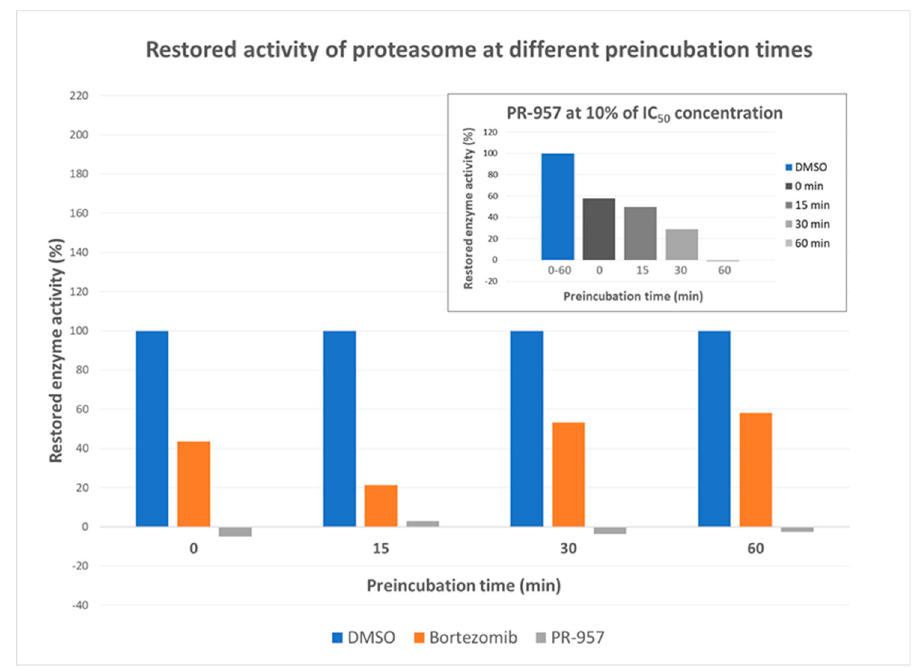
Figure 5. Dilution assay: Enzyme recovery after preincubation with the inhibitor for 0, 25, 30 or 60 min was observed and compared to DMSO control. Over longer preincubation time bortezomib caused significant loss of enzyme activity (up to approximately 45%) compared to the DMSO control at concentrations equal or higher than the inhibitor’s IC 50 value. The recovery of proteasome seems to be slowly increasing with longer preincubation time. On the other hand, PR-957 completely inhibited the enzyme at higher concentrations regardless of the preincubation time. However, a time-dependent inhibition was observed at lower concentrations (top right graph).